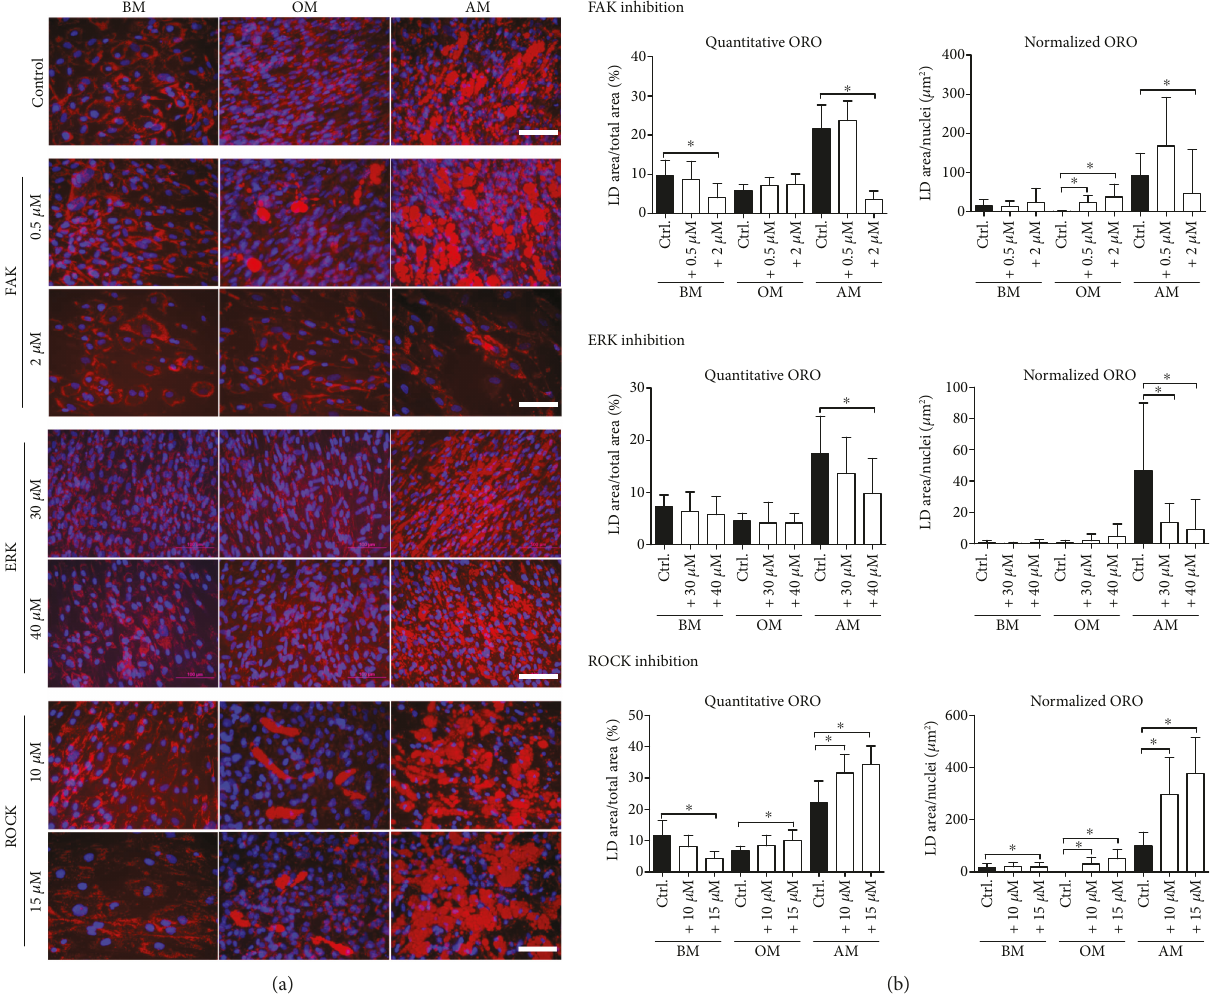
Figure 5: ORO staining of hASCs and quanti fi cation of lipid accumulation from ORO-stained fl uorescence images. (a) Representative ORO- and DAPI-stained fl uorescence images of FAK, ERK, and ROCK inhibitor-treated hASCs at 21 d. Human ASCs were stained with ORO for intracellular lipid accumulation followed by nuclei staining with DAPI. Fluorescence images were taken with Alexa546 for ORO (red) and DAPI (blue) fi lters. Scale bars 100 μ m. (b) ORO-stained samples of FAK, ERK, and ROCK inhibitor-treated hASCs were imaged with fl uorescence microscope using Alexa546 and DAPI fi lters and analyzed with a custom analysis pipeline designed for CellPro fi ler. Quantitative ORO graph presents the area of all stained LDs as percentages of the total image area. Normalized ORO graph describes LD formation on the single cell level: the area of LD clusters over 10 μ m in diameter is normalized with the corresponding nuclei